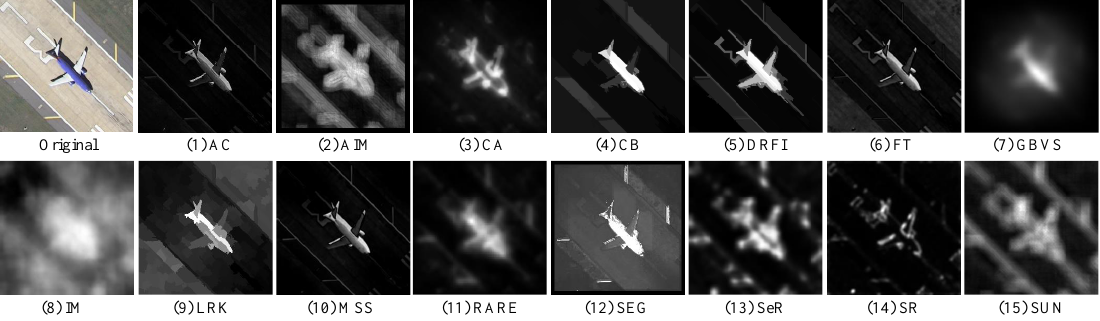
Figure 6. Saliency maps computed by different state-of-the-art saliency detection methods (1–15). Most maps highlight the edges of the salient object (airplane), and are of low resolution compared to the original